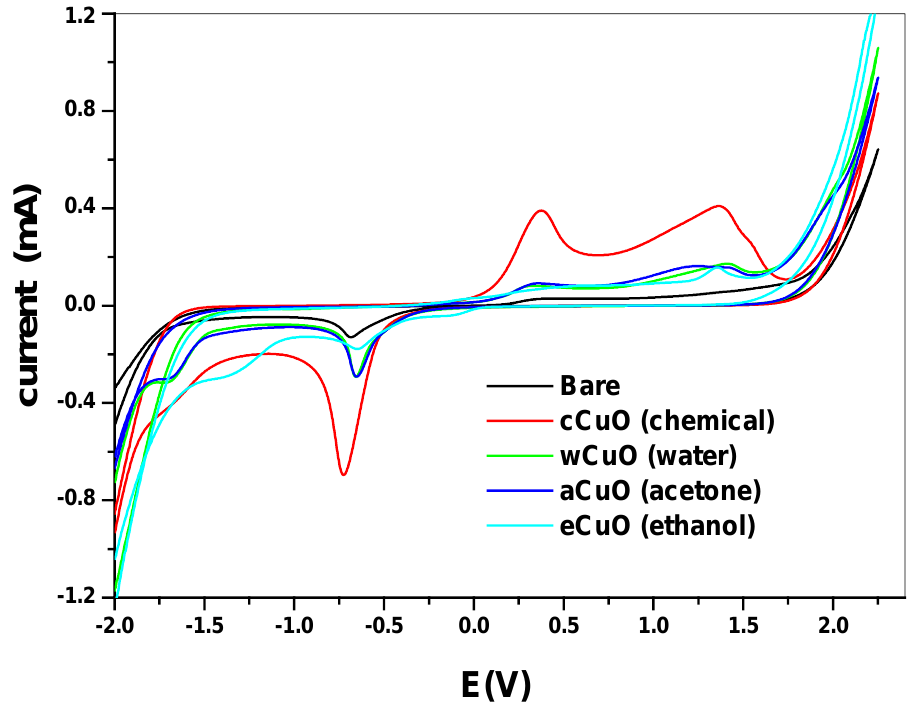
Figure 7. Cyclic voltammograms of the bare screen printed carbon electrode (SPC) and SPC modified with chemical and green synthesis using di ff erent solvent in 10 mM [Fe(CN) 6 ] 4 − / [Fe(CN) 6 ] 3 −